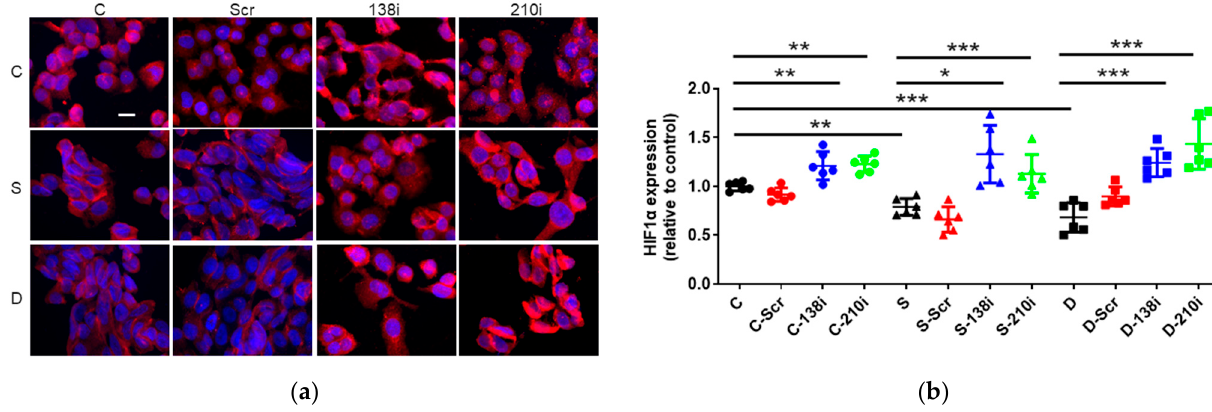
Figure 4. The HIF-1 α expression changes after inhalational anesthesia with miRNA inhibitor pretreatment in neuroglioma (H4) cells. ( a ) HIF-1 α immuno-fluorescence staining, HIF-1 α (red) in control (upper), sevoflurane- (middle) and desflurane-treated (bottom) H4 cells with miRNA inhibitor pretreatment, counterstained with DAPI (blue); ×20 magnification, scale bar = 20 μ m. ( b ) The comparison of the HIF-1 α immunofluorescence intensity with each anesthetic and miRNA inhibitor pretreatment. Data showed as plots and mean ± SD. * p < 0.05, ** p < 0.01, *** p < 0.001, n = 6. One-way ANOVA with Tukey-Kramer compared to each control group. C: control, S: sevoflurane, D: desflurane, Scr: scrambled miRNA, 138i: miR-138 inhibitor and 210i: miR-210 inhibitor.